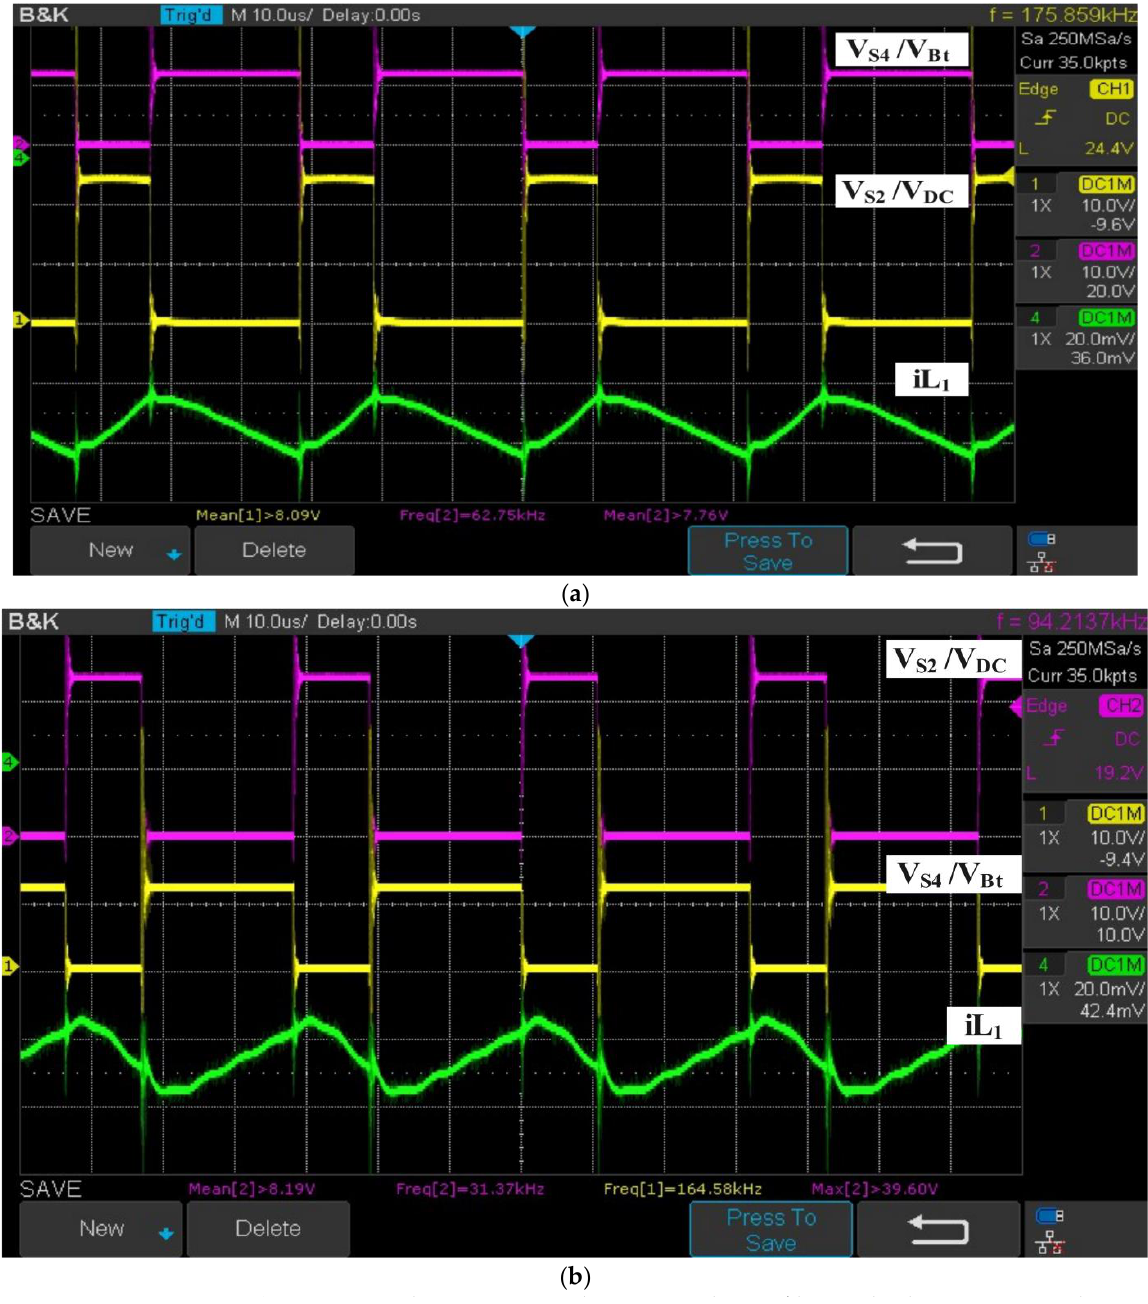
Figure 18. ( a ) Voltage across switch S 2 , VS2 (scale: 20 V/div), and voltage across switch S 4 , VS4 (scale: 10 V/div). ( b ) Mode 1(b): voltage across switch S 2 , V S2 (scale: 20 V/div), and voltage across switch S 4 , V S4 (scale: 10 V/div).